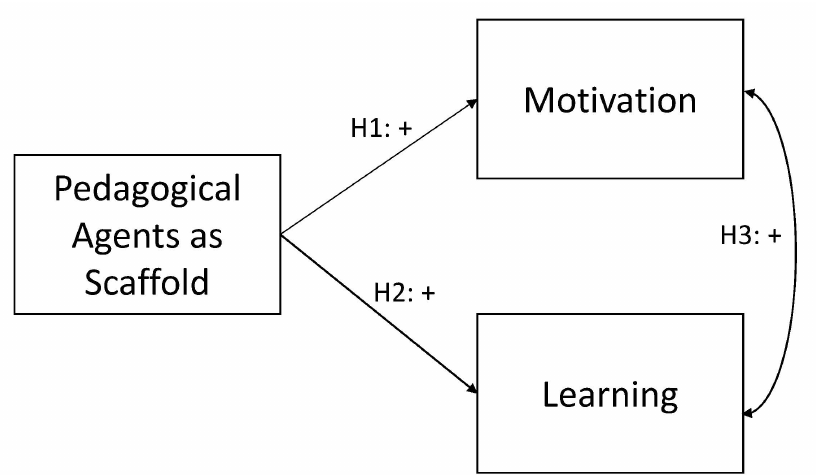
Figure 1. Hypotheses of the